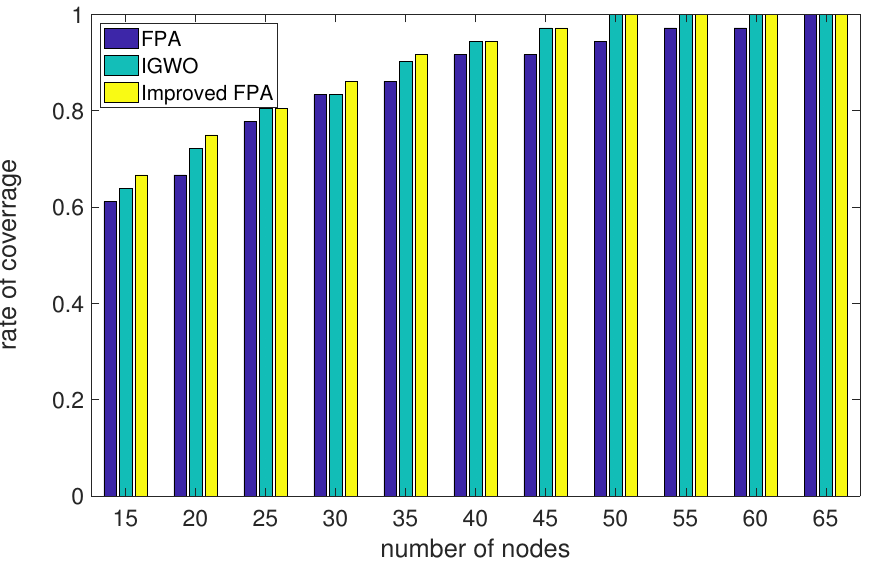
Figure 6. Coverage comparison of the three algorithms under different number of nodes. High coverage and low energy consumption are two main objectives considered in the coverage optimization of wireless sensor networks. The energy consumed by